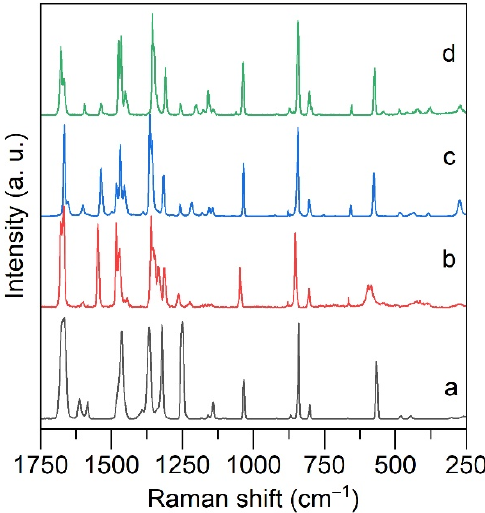
Figure 3. Raman spectra: a—isopropyl salicylate (HL), b—LiL, c—NaL, d—KL.